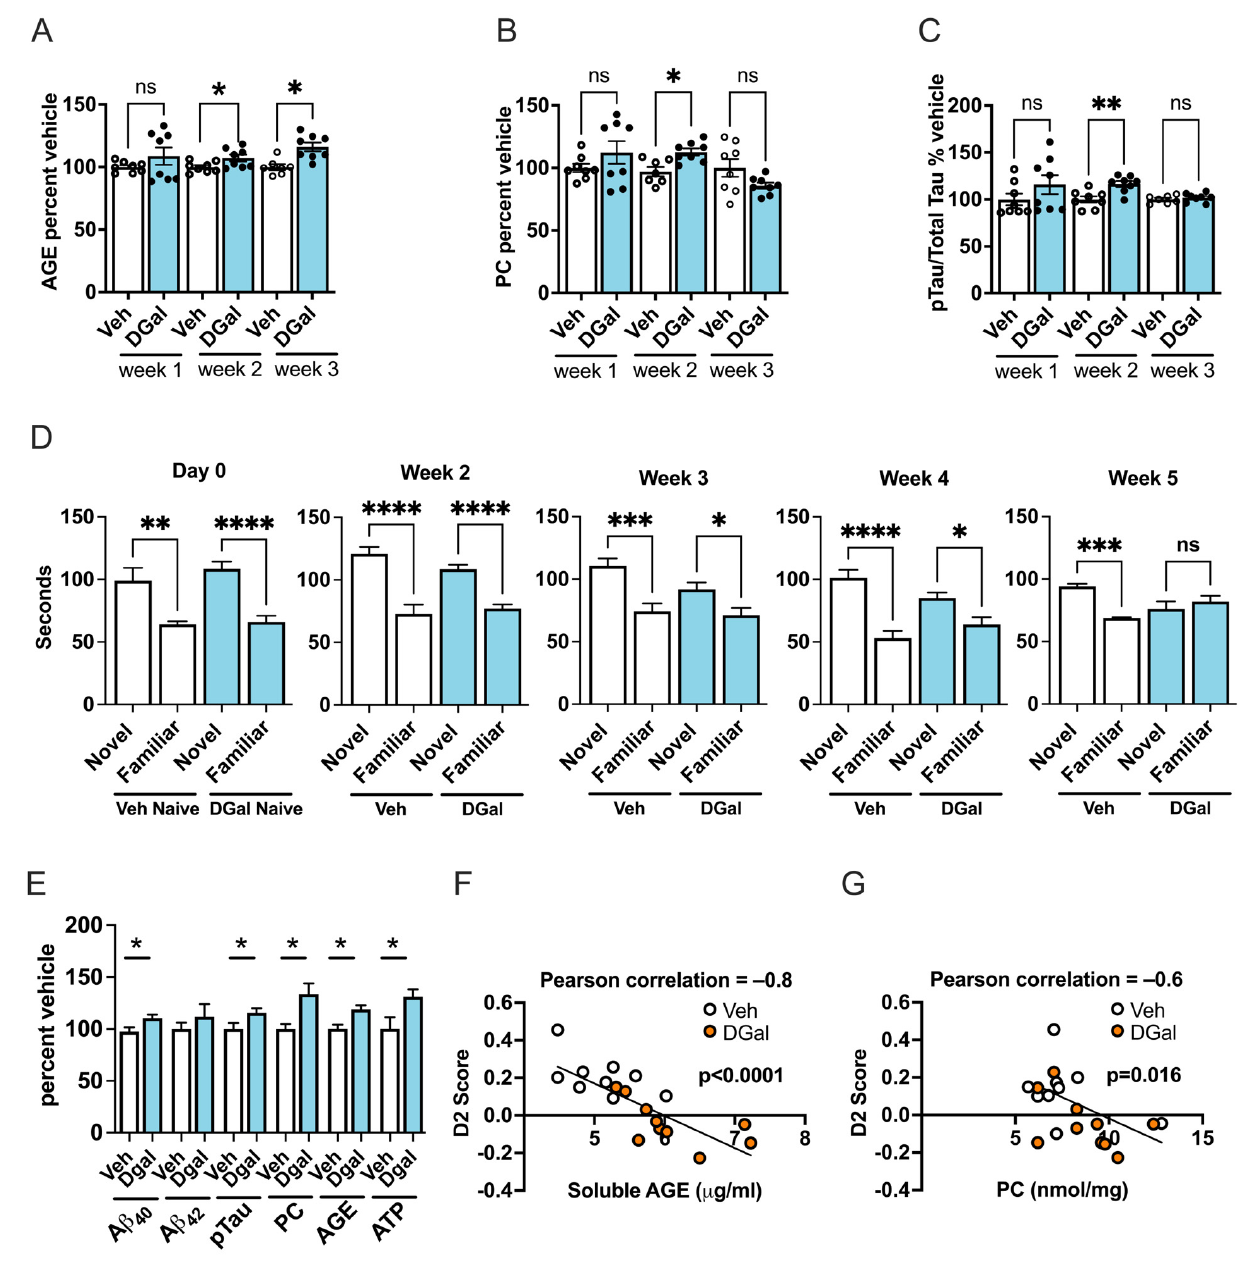
Figure 6. AD-like pathologies precipitate in the hippocampus ahead of other brain regions. AGE ( A ), PCs ( B ), and p-tau ( C ) levels in the soluble hippocampal fraction for mice dosed chronically over 1, 2 or 3 weeks with vehicle (Veh) or 4 g/kgoDGal. Hyperphosphorylated tau was detected using AT180 antibody-coupled MSD ELISA plates and normalized to total tau levels. In ( A ) AGE data are analyzed by one-way ANOVA ( F (5, 41) = 3.34, p = 0.013) followed by Dunnett’s multiple comparison test and unpaired student t -test; ( B ) PC ( F (5, 20.83) = 3.66, p = 0.016) and ( C ) p-tau ( F (5, 18.66) = 4.47, p = 0.0076) data are analyzed by Brown–Forsythe and Welch ANOVA followed by Dunnett’s T3 multiple comparison test. ( D ) Spatial recognition test (SRT) represented as exploration time, in seconds, of familiar and novel locations for vehicle (Veh) or 4 g/kgoDGal. Animals were dosed chronically for periods depicted in the figures. Data were analyzed by one-way ANOVA; Day 0: ( F (3, 36) = 13.49, p < 0.0001), week 2: ( F (3, 34) = 24.22, p < 0.0001), week 3: ( F (3, 36) = 8.47, p = 0.0002), week 4: ( F (3, 44) = 14.68, p < 0.0001), and week 5: ( F (3, 28) = 7.18, p = 0.001) followed by Dunnett’s multiple comparison test. ( E ) Representation of A β 40 , A β 42 , p-Tau, PC, AGE, and ATP detected in the soluble hippocampal fraction from animals dosed chronically over 5 weeks with vehicle (Veh) or 4 g/kgoDGal. Data were analyzed by unpaired Mann–Whitney nonparametric t -test. Asterix (*) represent significant